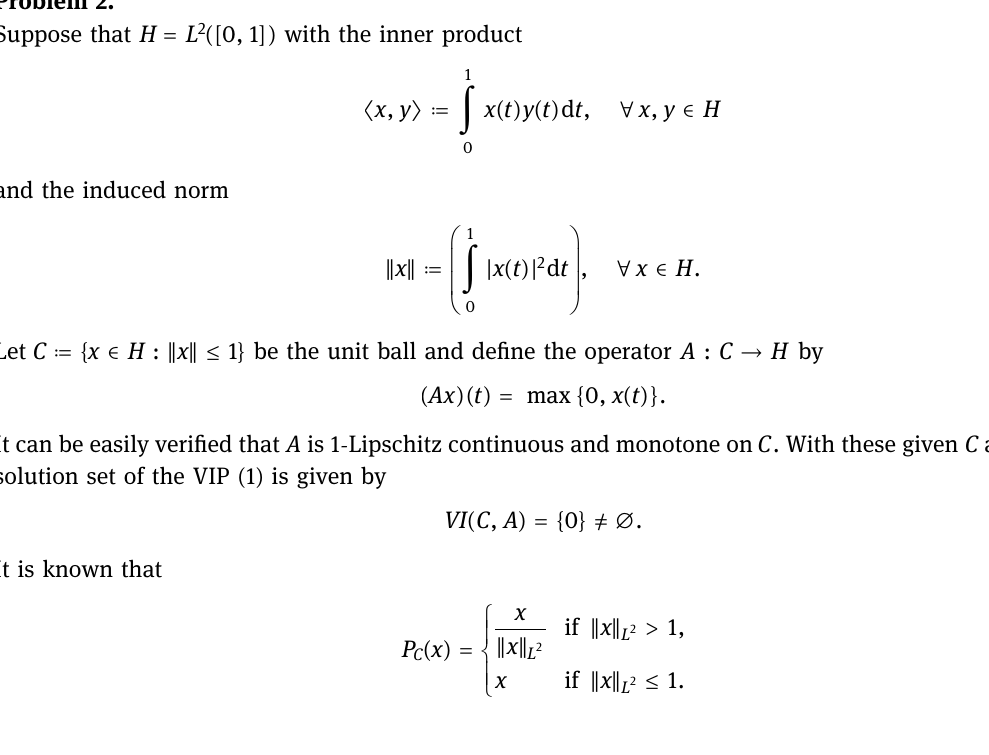
Table 1: Comparison between Algorithms 3.1, 1.1, and 1.2 for Problem 1 Dimension